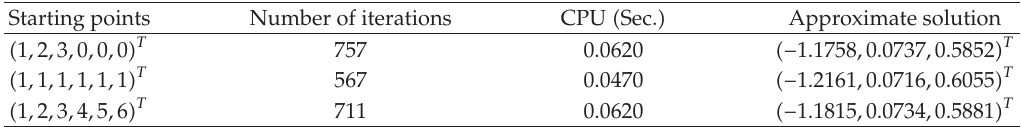
Table 6: Results for Example 6.2 using EG type HRP method.